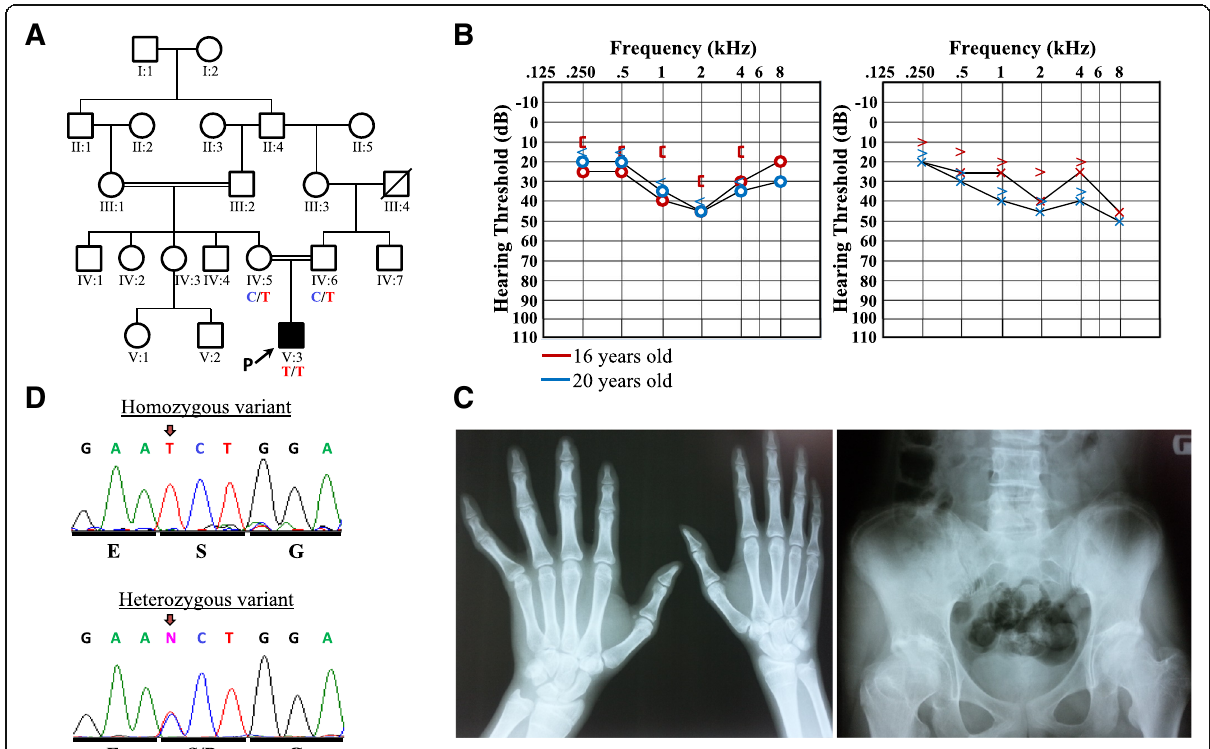
Fig. 1 Pedigree of patient 1, pure-tone audiograms, radiological examinations, and sequence electropherogram. a The proband ’ s parents are first- degree cousins. There is no family history of CAGSSS. Genotype results for the c.2725C > T variant are represented under the tested individuals. b Pure-tone audiograms from proband 1 at 16 (red) and 20 (blue) years of age reveal stable, sensorineural hearing loss. Right air conduction (circle), unmasked bone conduction (bracket), and masked bone conduction (<) and left air conduction (x) and unmasked bone conduction (>) are shown from left to right, respectively. c Radiological images depicting epiphyseal dysplasia of the distal radius and fingers with tapering (left) and right hip with shortened femoral neck due to metaphyseal dysplasia (right). d Electropherograms of the homozygous proband (upper panel) and representative heterozygous electrophenogram from a parent (lower panel) showing the nucleotide and amino acid exchange. The variant position is marked with a red